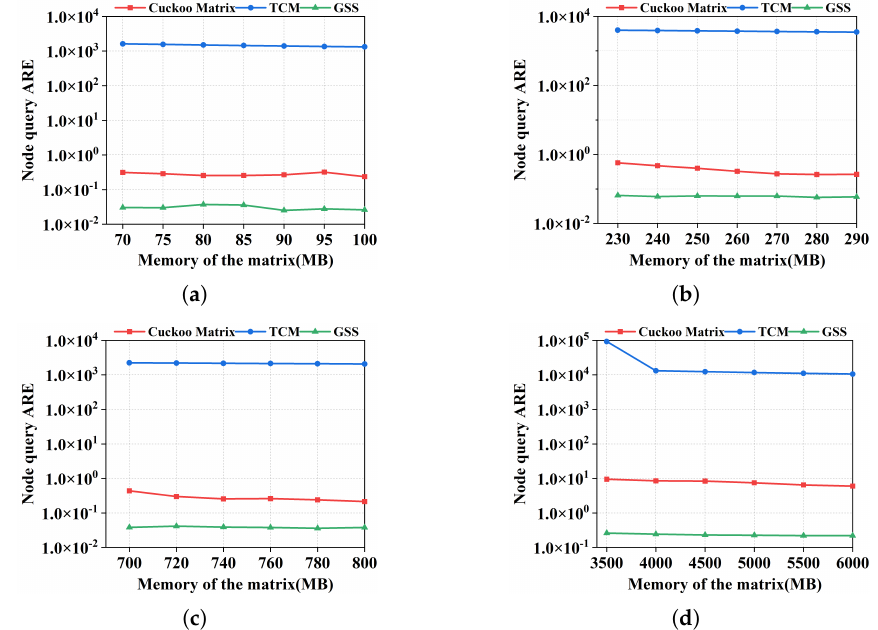
Figure 6. Average relative error of node queries. ( a ) Skitter. ( b ) DBLP. ( c ) Orkut. ( d ) Wiki.